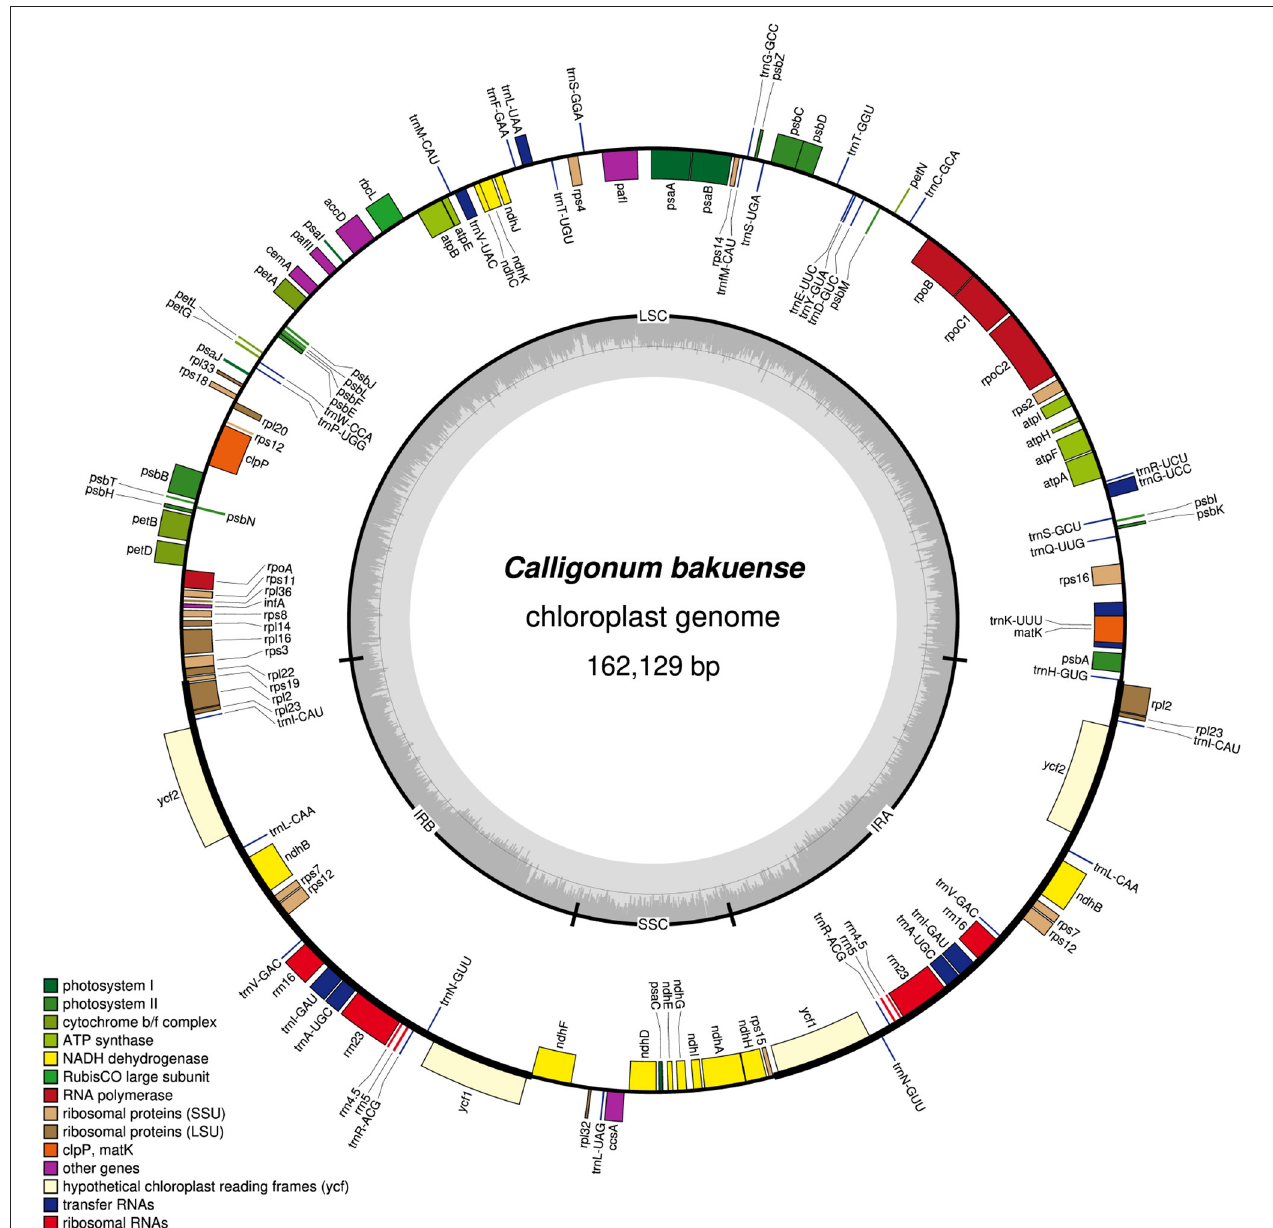
FIGURE 2 | Map of the complete plastid genome of individual Cb01A of C. bakuense as assembled by GetOrganelle under a coverage cap of 500x. This assembly represents the final plastid genome sequence for Cb01A. genome assembly for C. bakuense in the shortest amount of time (7 min. and 6 min. for Cb01A and Cb04B, respectively); for lower levels of sequencing coverage, GetOrganelle was the software to achieve complete assemblies